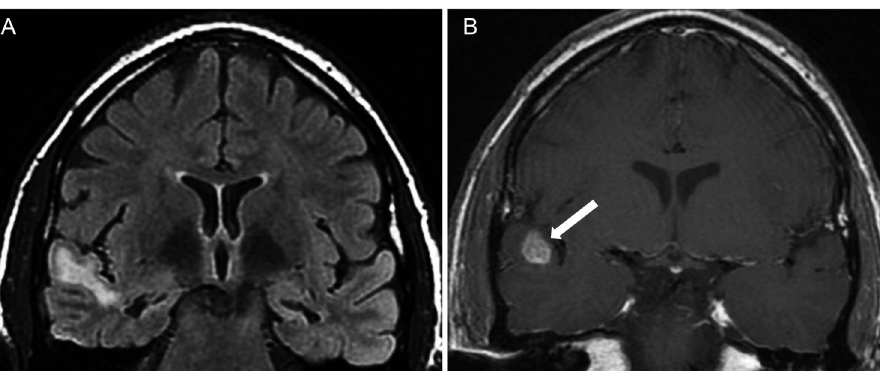
Figure 2 - Bilateral hippocampal sclerosis and ‘‘ dual pathology ’’ in a 34-year-old woman. A) Coronal FLAIR image showing bilateral hippocampal atrophy and hyperintensity as well as a hyperintense lesion in the right superior temporal gyrus. B) Coronal T1-weighted